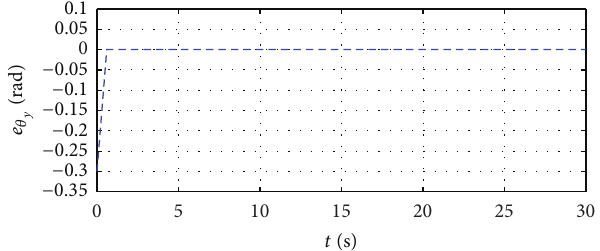
Figure 11: Theta error in 𝑦 direction. The error of angel theta in 𝑦 direction reaches its desired value which can be observed in the figure. The error tends to zero after 0.6 seconds.